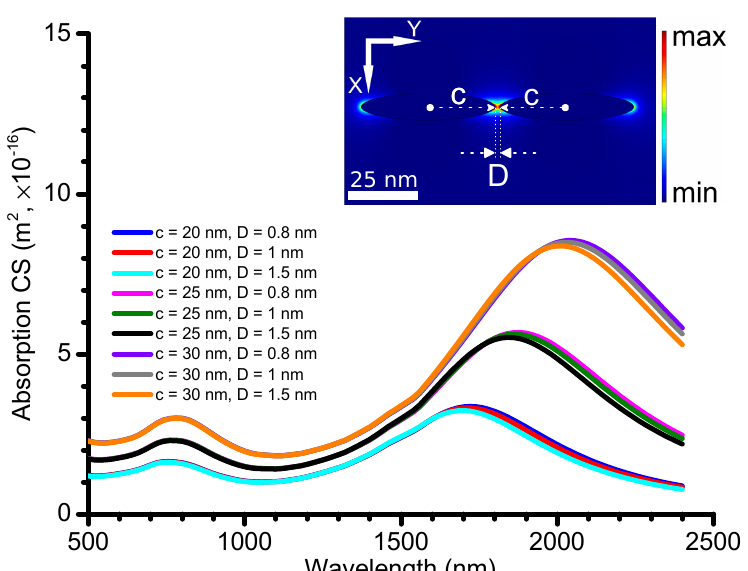
Figure 6. Simulated absorption CS of coupled MXene nanospheroids in end-to-end configuration with equal short semiaxes ( a = b = 5 nm) and varying long semiaxis ( c = 20, 25 or 30 nm). Inset: electric field intensity map in the case of coupled spheroids with semiaxis c = 25 nm and a = b = 5 nm, irradiated by parallel electric field at 760